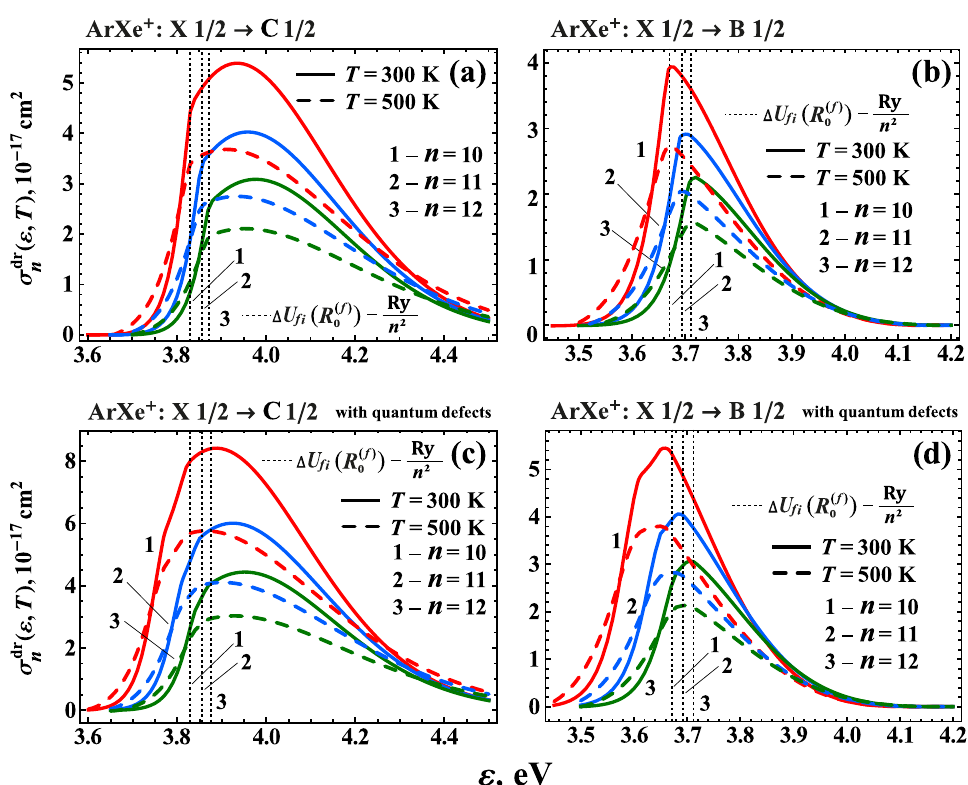
Figure 8. Cross sections of dissociative recombination (18) of ArXe + ions in collisions leading to population of any nl -sublevels of Ar( n ) states with n = 10, 11, 12 calculated without ( a , b ) and with ( c , d ) the account of non-zero quantum defects of low- l states. ( a , c ): reactions accompanied by A -type transitions, ArXe + ( X 1/2 ) + e → ArXe ( C 1/2, nl ) → Xe + Ar ( 2 P 1/2 nl ) . ( b , d ): same for B -type transitions, ArXe + ( X 1/2 ) + e → ArXe ( B 1/2, nl ) → Xe + Ar ( 2 P 3/2 nl ) . Calculations were carried out for gas temperatures T = 300 and 500